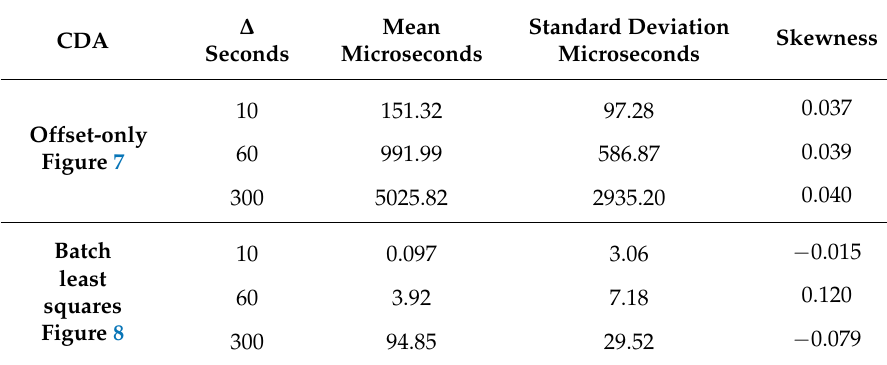
Table 5. Statistics of CDA